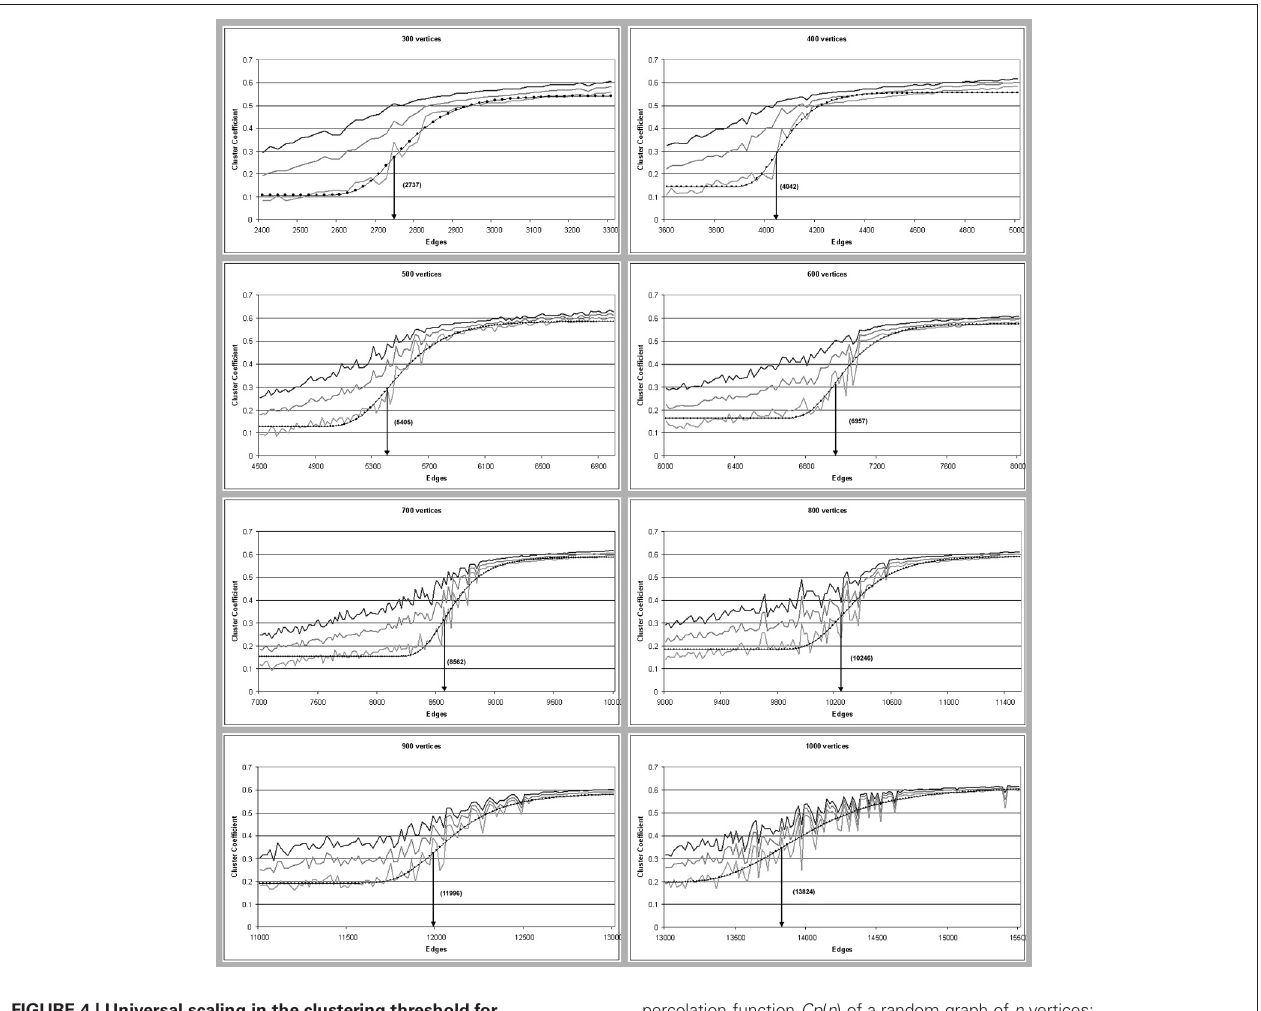
FIGURE 4 | Universal scaling in the clustering threshold for self-organized small-world networks. Gray lines represent minimal, maximal and average observed values for clustering coefficient, the dotted line is the predicted clustering coefficient, CCpred, a linear function of the